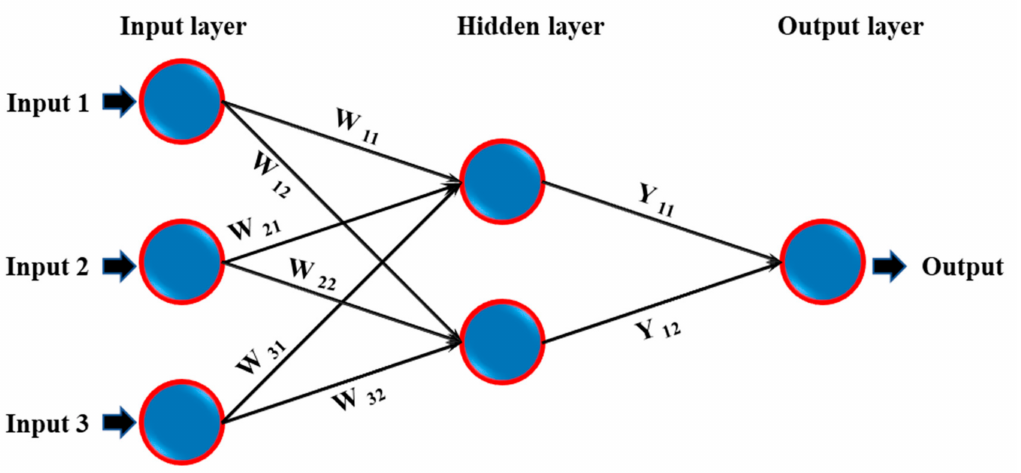
Figure 9. Simplified ANN architecture with a single hidden